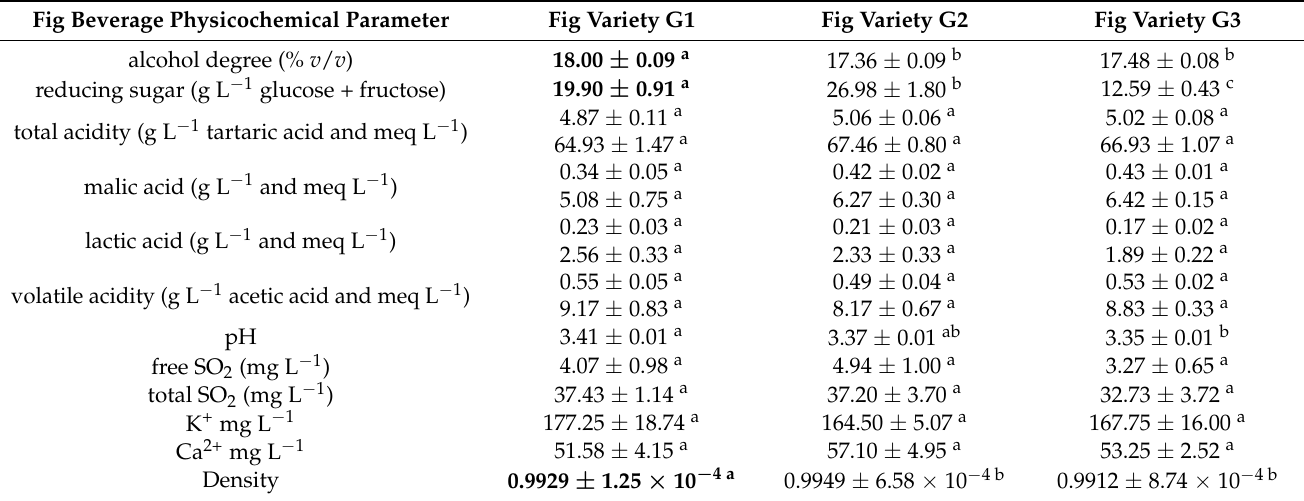
Table 2. Main physicochemical parameters of the fermented alcoholic beverages from the three varieties of